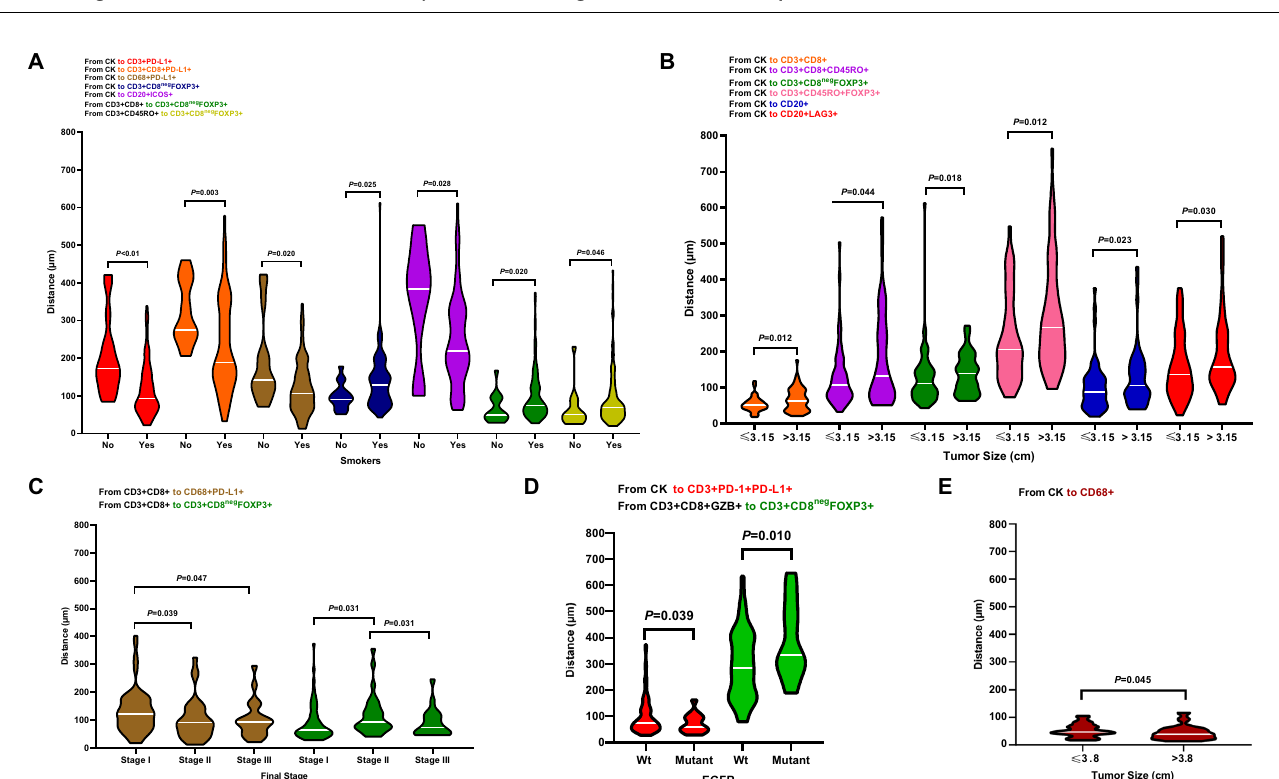
squamous cell carcinoma ( n =83) specimens. Violin plots showing the median bar value, lower adjacent value and outside points. Kruskal – Wallis test was used in A – D comparisons between groups. Data from 225 samples was used. Graphs were generated using GraphPad Prism v.9.0.0 using the 26 cell phenotypes distribution patternsandtherelevantclinicopathologicinformationusingun-adjusted P -values. (Source data is provided as a source data fi